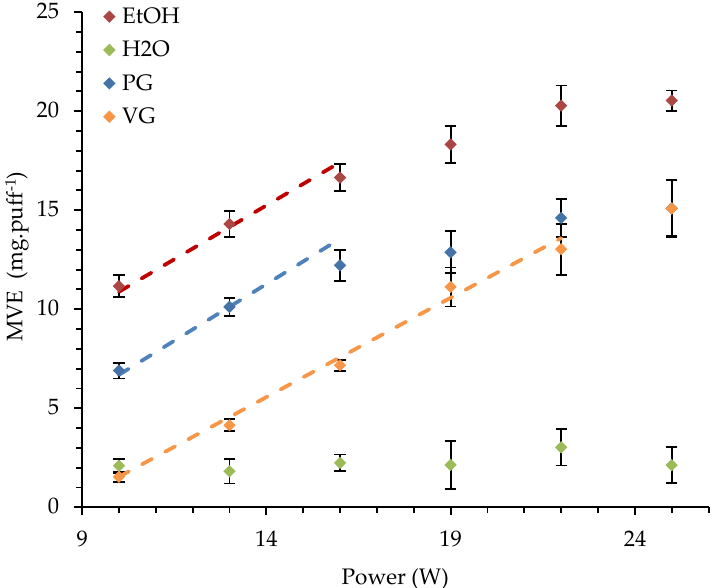
Figure 2. Influence of the supplied power on the mass of vaporized e-liquid (MVE) (dots) of pure liquids (ethanol (EtOH), propylene-glycol (PG), glycerol (VG), and water (H 2 O)) and optimal regimes (in dash line) of EtOH, PG, and VG.